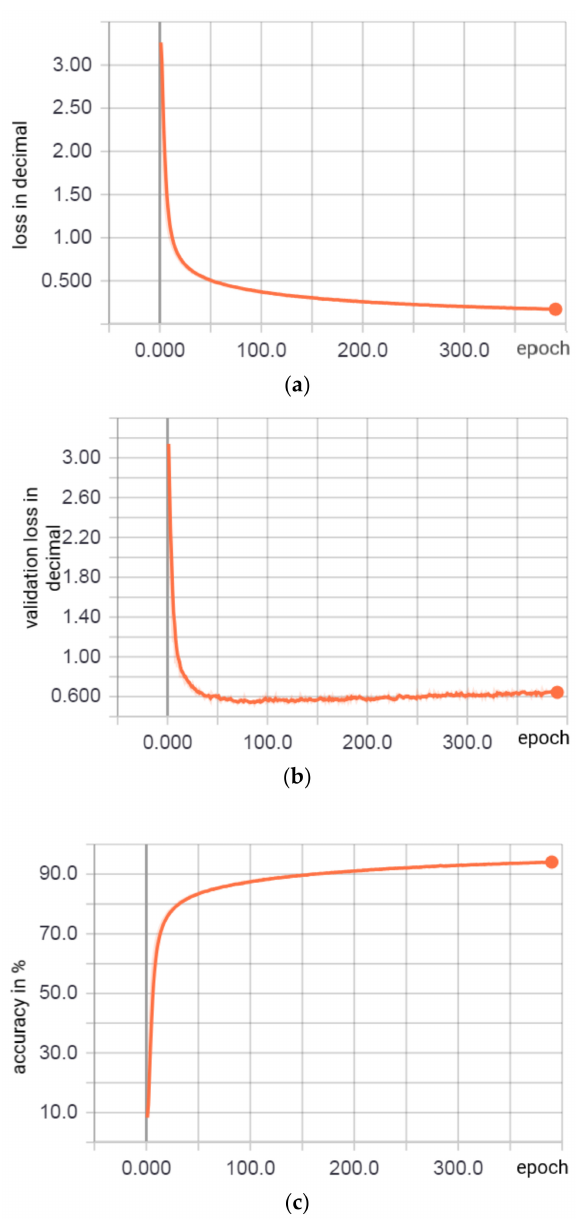
Figure 9. Performance of the classifier, where ( a ) represent the loss graph, where our classifier shows a decrease in the loss during the training phase; ( b ) represent the validation graph, which shows the reduction of the loss and the increase in the confidence of our classifier during the validation phase; and ( c ) show the accuracy graph, which shows an increase in accuracy of up to 91% after 350